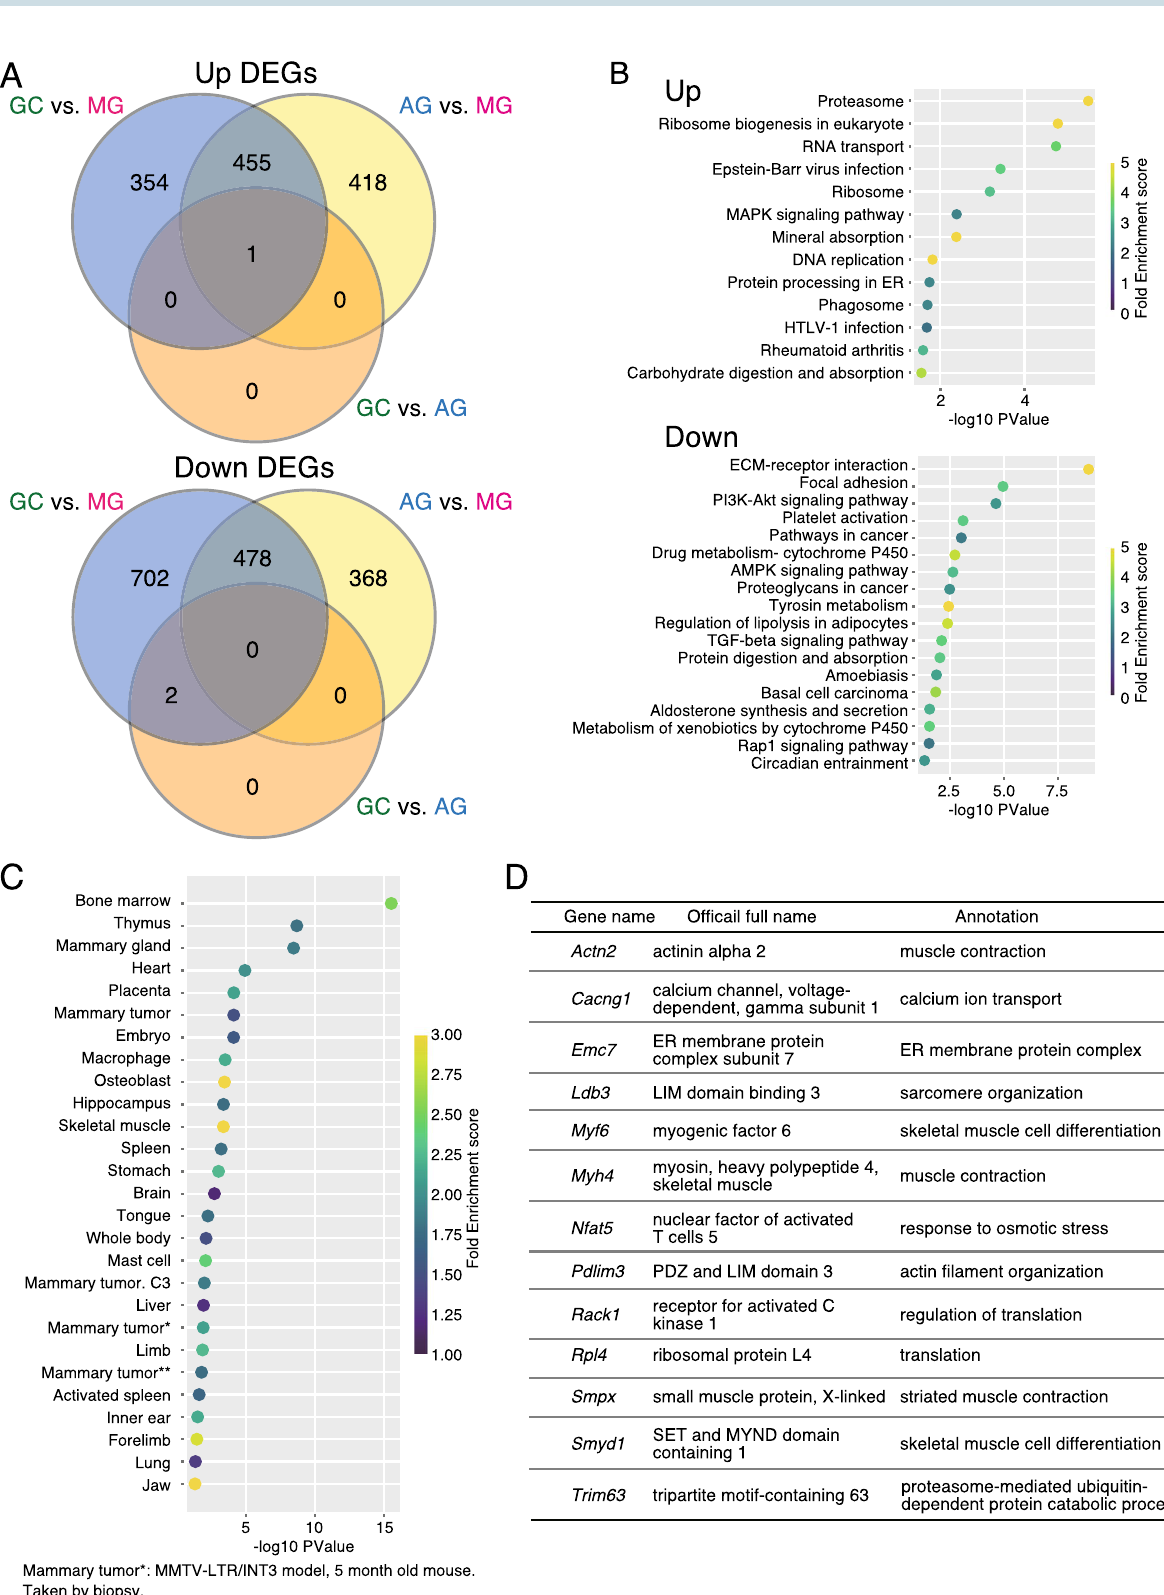
Figure 4. Pathway analysis of changed genes between MG and GC, and MG and AG, and identifying novel candidate genes involved in muscle atrophy. ( A ) Venn diagram showing the number of upregulated (upper) and downregulated (lower) DEGs in each comparison between MG, GC, and AG. ( B ) Pathway analysis of upregulated (upper) and downregulated (lower) DEGs in the overlapping region of MG compared with GC and AG. ( C ) Tissue expression profiles of 418 upregulated DEGs in MG compared with AG. ( D ) The gene list showing skeletal muscle- related genes from Fig.